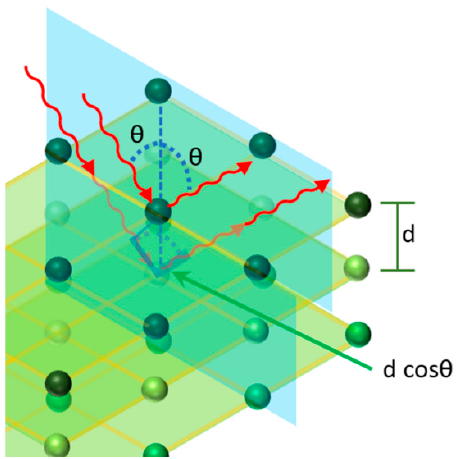
Figure 3. Scheme of the light reflection from ordered spherical particles by analogy with X-ray diffraction, where different wavelengths are diffracted at different angles.